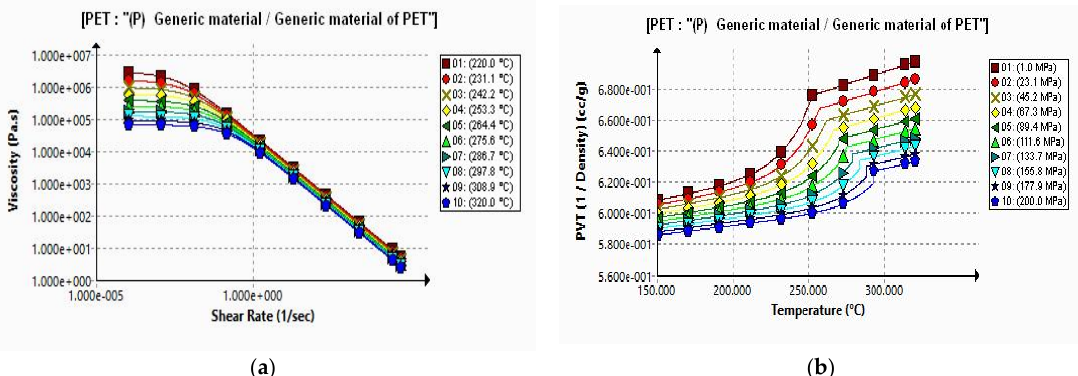
Figure 11. ( a ) Viscosity v/s Shear Rate Curves. ( b ) Specific Volume v/s Temperature Curve.